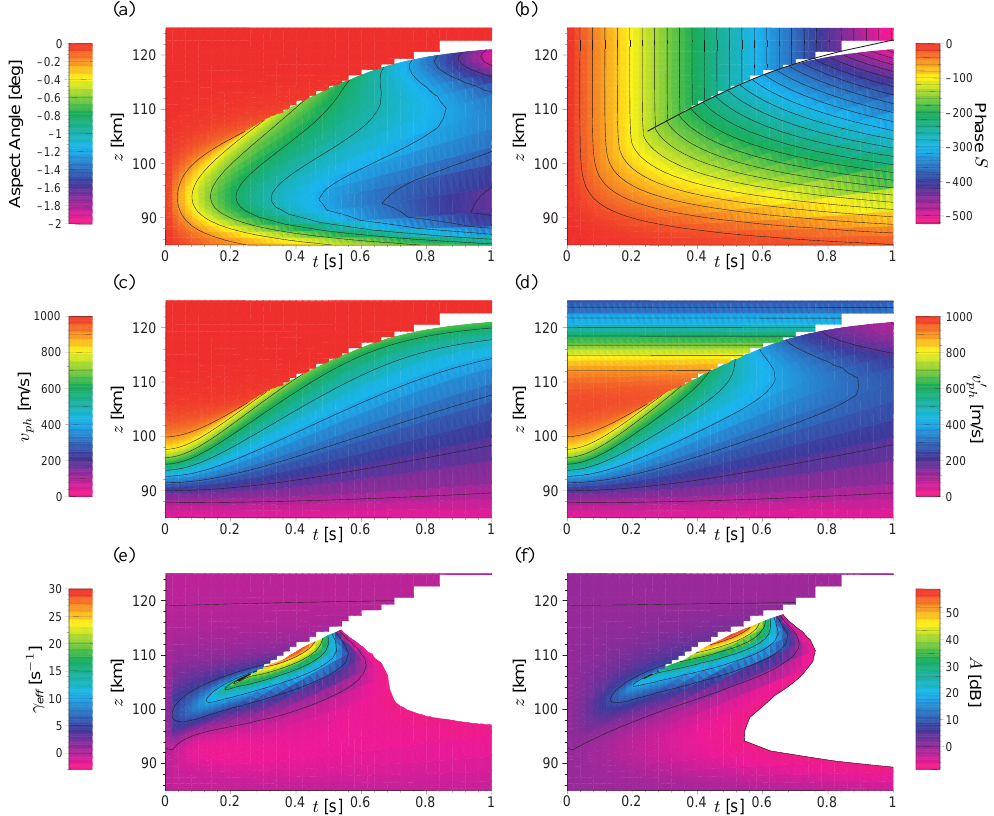
Fig. 5. Results from the benchmark run at λ = 12 m, V d = 1000 m/s, and T e = T n . Contour levels are given by the corresponding horizontal lines on the color bar. The white spaces associated with a step function-like staircase are produced when characteristics are being terminated to avoid crossing. The limitations of the plotting package are responsible for the dented look. The rest of the white areas associated with growth rate plots are in regions for which the growth rate is too negative to